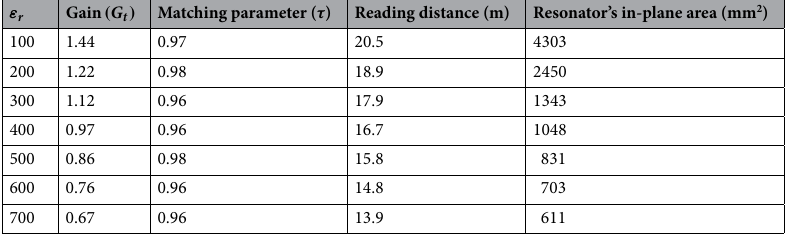
Table 1. Numerically calculated parameters of the ceramic tag with different values of dielectric permittivity.